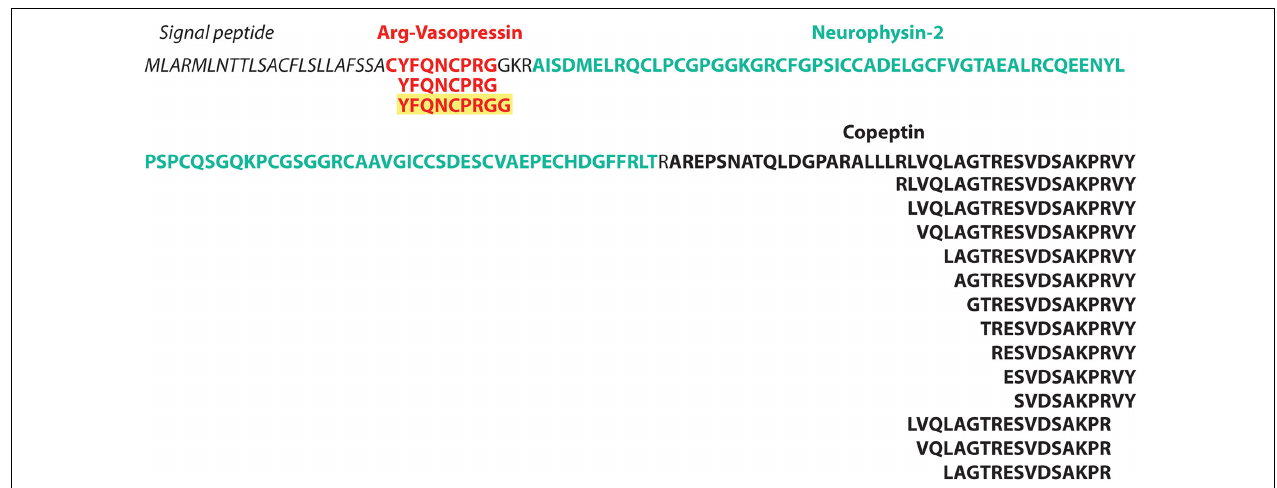
FIGURE 4 | timsTOF data enables study of endogenous proteolytic processes. Illustration of the neuropeptide precursor Vasopressin-neurophysin 2-copeptin (P35455) and the annotated peptides as reported in Uniprot in bold. Below are the MS-identified peptides illustrating the proteolytic process. The peptide in yellow was identified in this study, but not present in the Neuropep reference database or annotated in